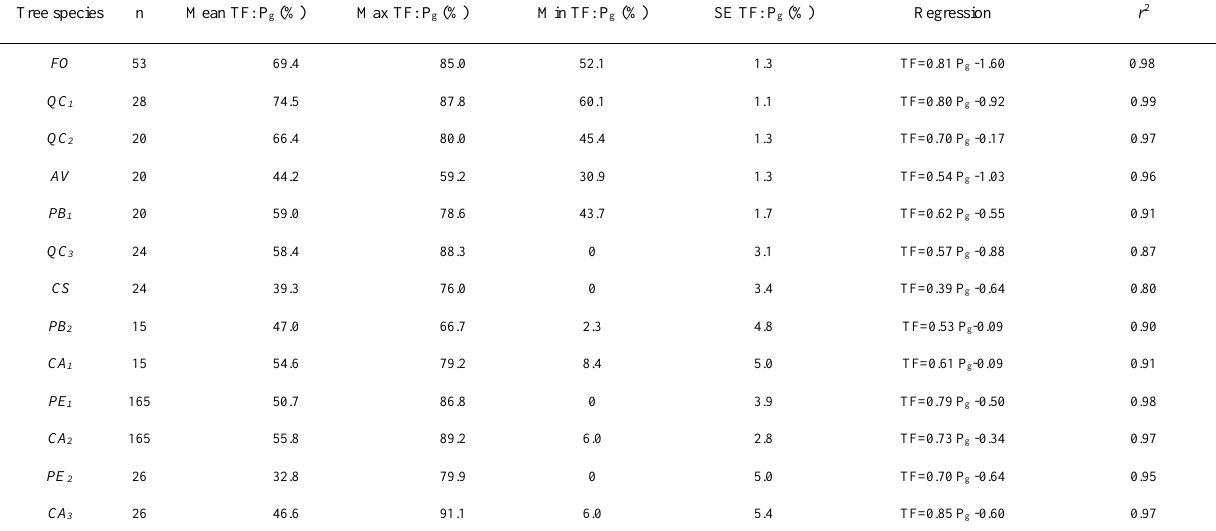
Table 3. Relationships between throughfall (TF) and rain event magnitude (P g ), percent of event based average relative throughfall (TF: P g ), and related statistics. See Table 1 for the tree species represented by the location codes. n refers to the number of recorded events. Tree